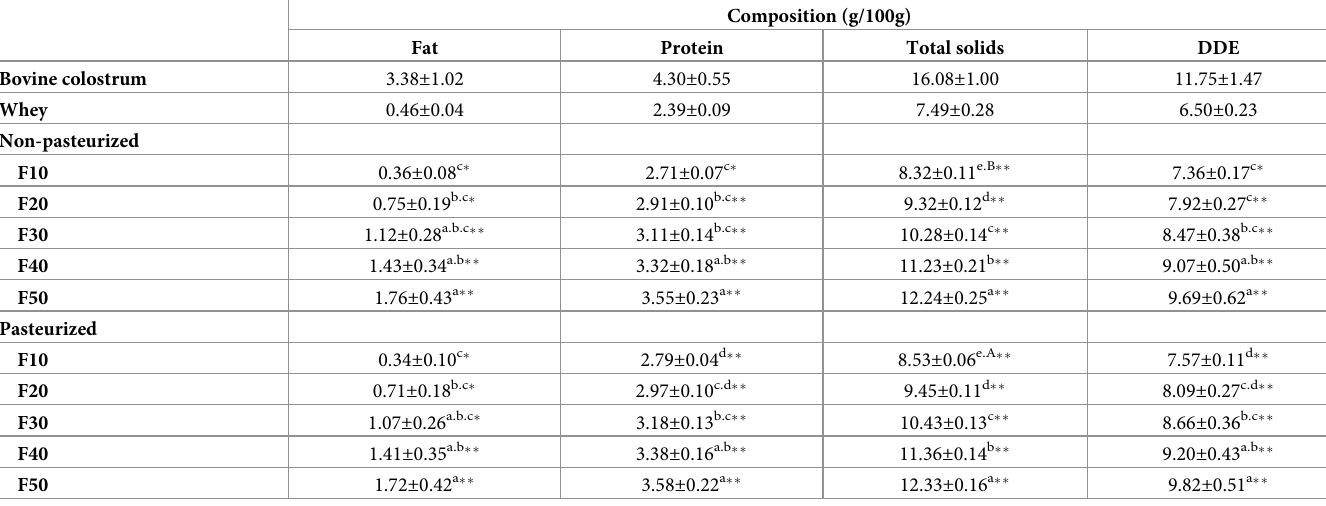
Table 1. Chemical composition (g/100g) of liquid formulations according to the addition of bovine colostrum and pasteurization, and comparison of the chemical composition of the formulations with the chemical compositions of bovine colostrum and